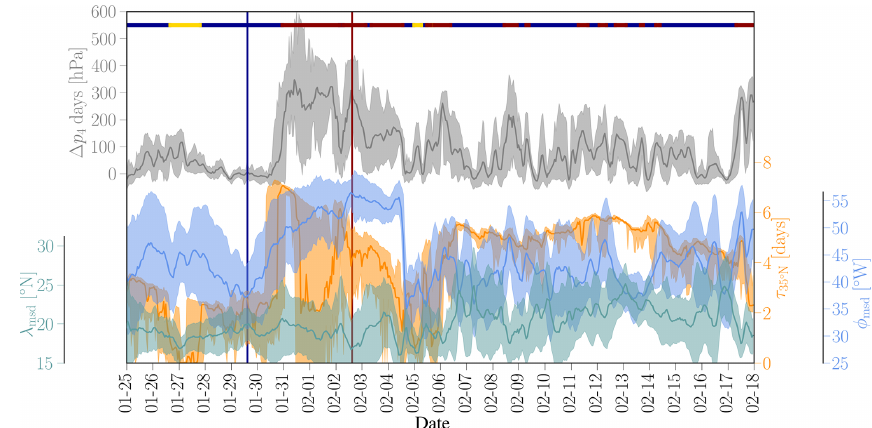
Figure 7. Lagrangian diagnostics for air parcels arriving in the sub-cloud layer ( p ≥ 940hPa) above Barbados. The slantwise subsidence in 4d, (cid:49)p 4d , in grey corresponds to the difference between the arrival pressure and the pressure of the air parcels 4d before arrival. The residence time of air masses in the extratropics τ 35 in the 10d prior to their arrival is shown in orange. The weighted mean moisture source longitude ( ϕ msd ; blue) and latitude ( λ msd ; turquoise) represent the centre of mass of the area over which moisture was taken up by the air parcels; the shaded area shows the weighted standard deviation of the mean. The grey and orange lines for (cid:49)p 4d and τ 35 represent the medians and the shaded area the 10th and 90th percentiles of the respective distributions for the 40 trajectories per hourly time step. The coloured bars at the top indicate the regime classification, with blue for the extratropical trade wind regime, dark red for the extratropical dry intrusion regime and yellow for the tropical regime. The vertical lines indicate the time steps chosen for the case studies in Sect. 3.4 at 15:00UTC on 29 January 2020 and at 15:00UTC on 2 February 2020, respectively. The cloud patterns for these time steps are shown in Fig. 10 and the trajectories in Fig.